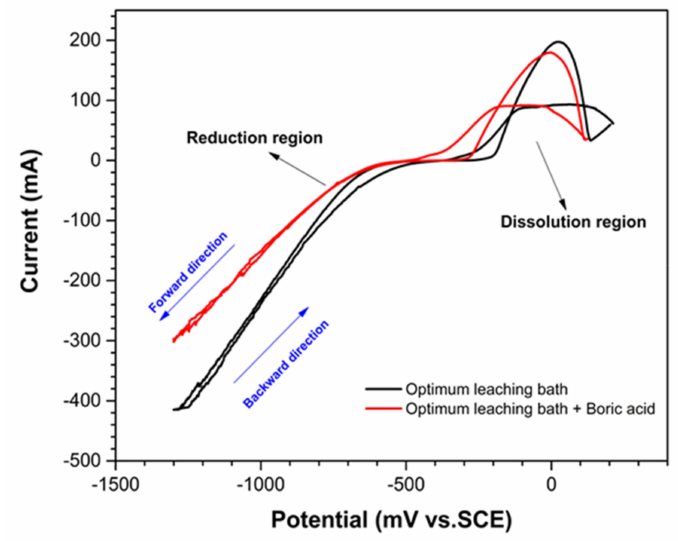
Figure 3. The cyclic voltammetry for electrodeposition onto plain carbon steel immersed in an optimum leaching bath of spent Li-ion batteries in presence and absence of boric acid. For a better clarity, the dissolution and reduction regions are